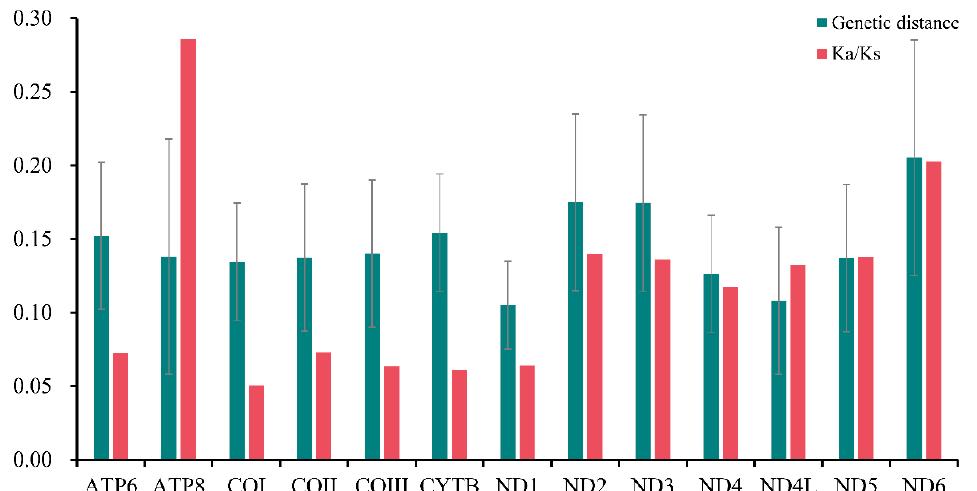
Figure 4. Ratios of nonsynonymous and synonymous substitution (Ka/Ks) and genetic distances of the 13 protein-coding genes of Sarcophagidae. Error bars refer to the standard deviation from all the combined data of all Sarcophagidae.